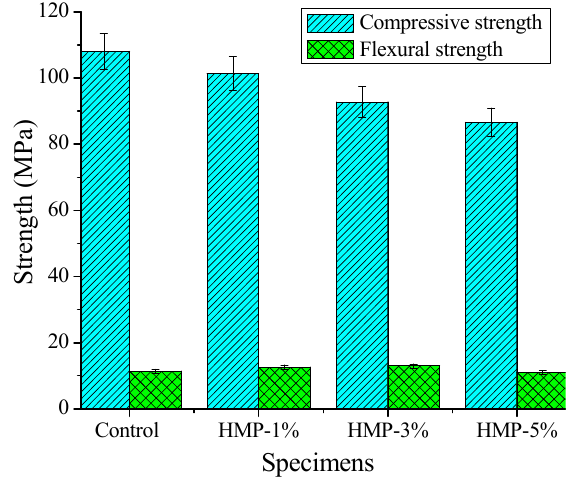
Figure 6. Compressive and flexural strength of control and HMP mortars.